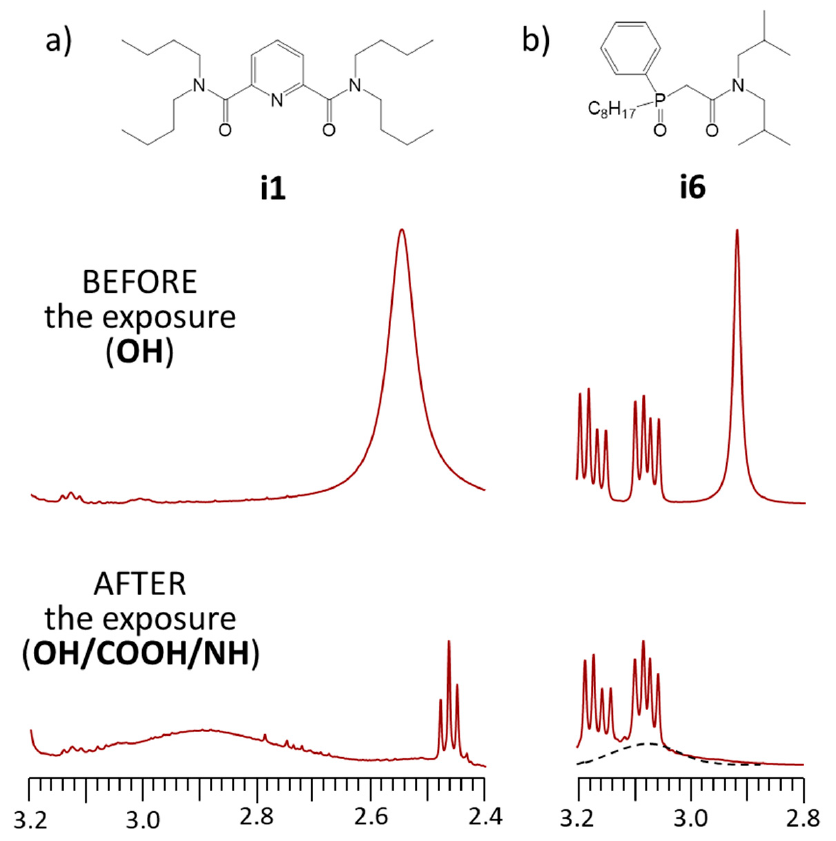
Figure 5. The parts of room temperature 1 H NMR spectra containing the OH/NH proton signals of nitrobenzene solutions of ( a ) i1 , ( b ) i6 before and after the exposure to ionizing radiation.